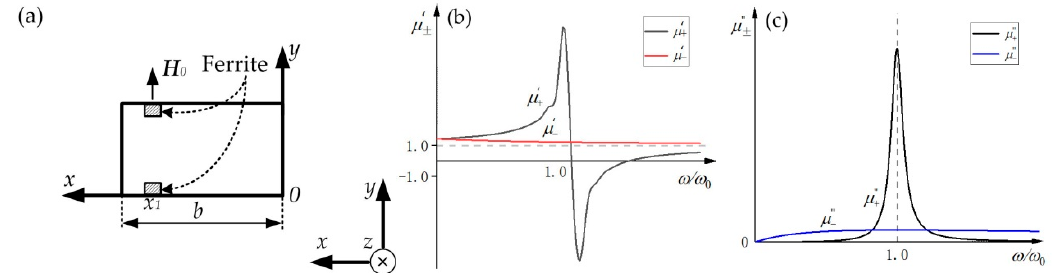
Figure 4. ( a ) The cross section view of the resonance isolator; ( b ) the variation of the real part of the effective permeability with ω / ω 0 ; and ( c ) the variation of the imaginary part of the effective permeability with ω / ω 0 .